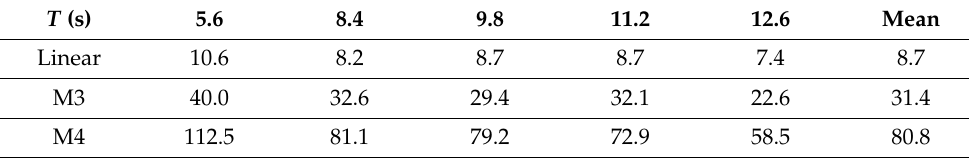
Table 4. Power estimation in full-scale versus varied wave period (unit: